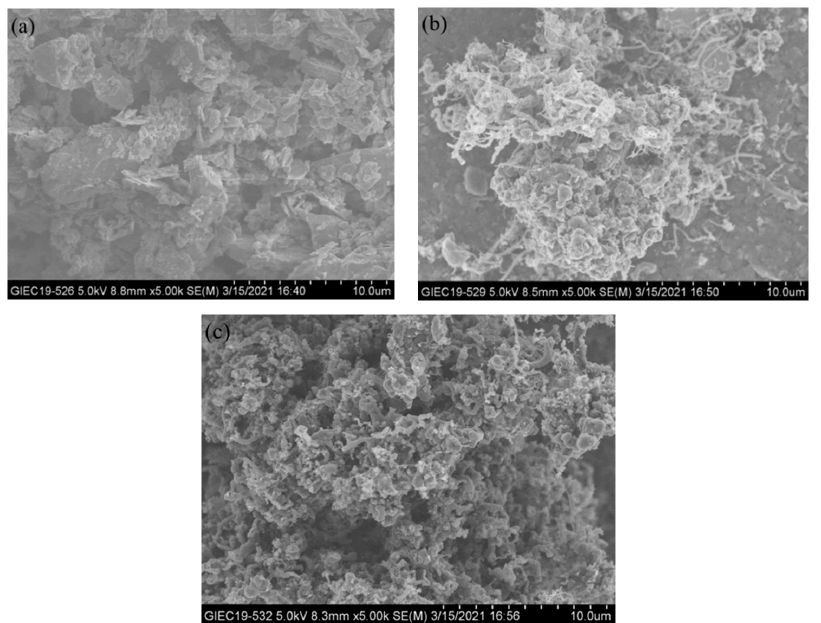
Figure 6. SEM image of OC: ( a ) original, ( b ) reduced, ( c ) reduced with H 2 O steam.